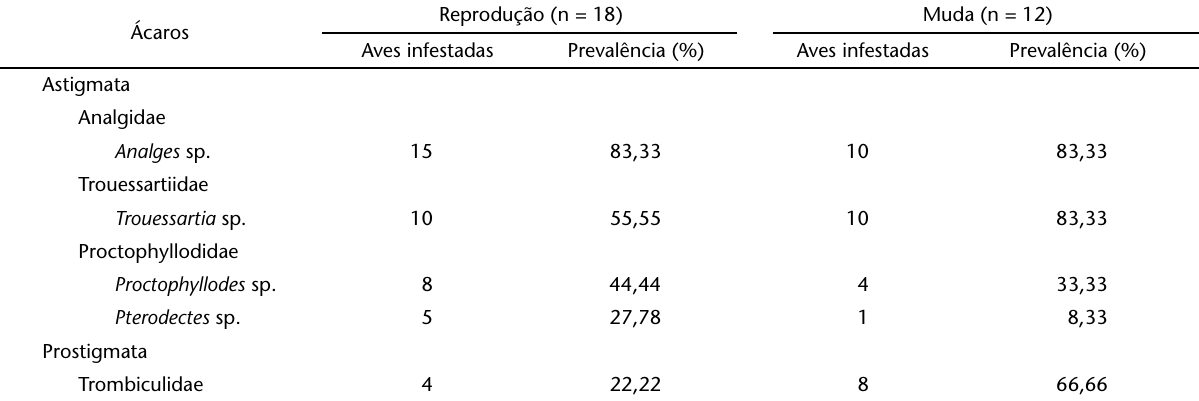
Tabela V. Prevalência de ácaros encontrados em T . leucomelas nas estações reprodutivas e de troca de penas (outubro e dezembro 2006/março 2007) no Parque Estadual do Rio Preto. (N) Número de indivíduos